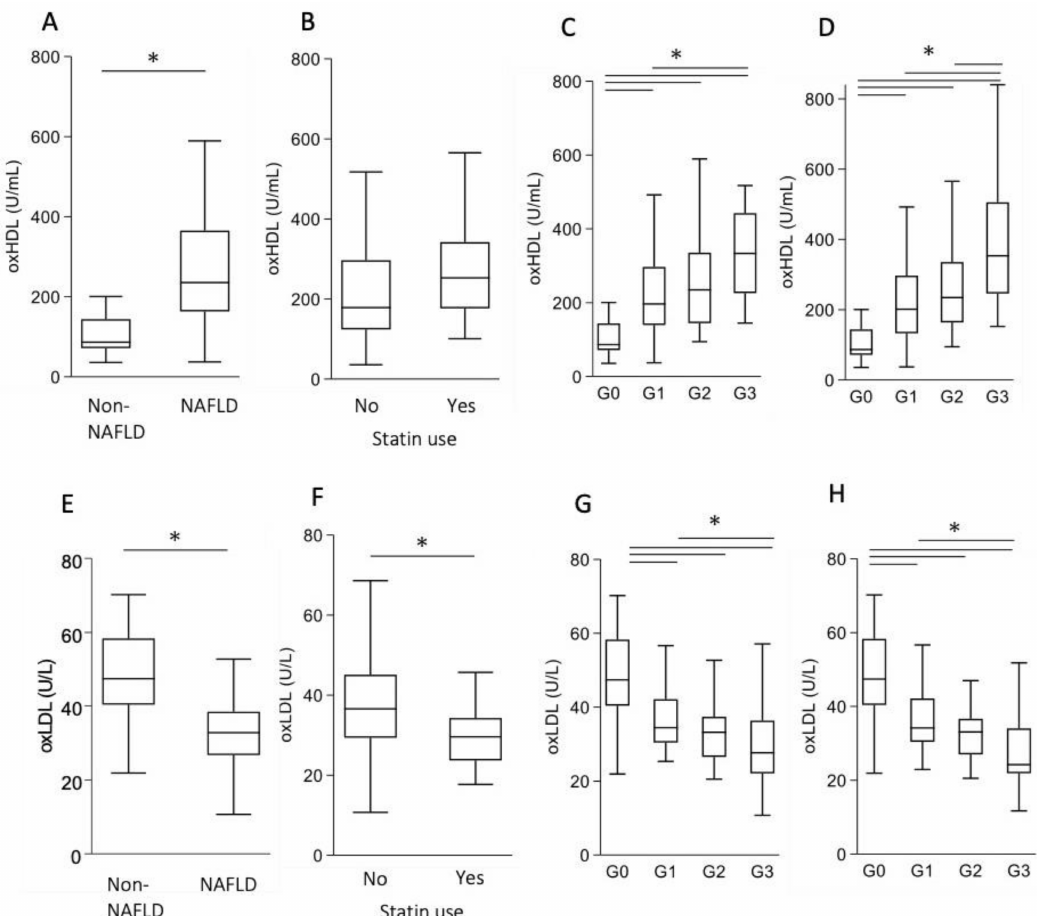
Figure 2. The levels of oxidized HDL (oxHDL) and oxLDL in non-NAFLD subjects and patients with NAFLD. ( A – D ) oxHDL levels. ( E – H ) oxLDL levels. ( A , E ) Non-NAFLD ( n = 32) versus NAFLD ( n = 106). ( B , F ) Non-statin use ( n = 77) versus statin use ( n = 29). ( C , G ) Lipid levels after stratification by the FIB-4 index. ( D , H ) Lipid levels after stratification by the NFS. * p <